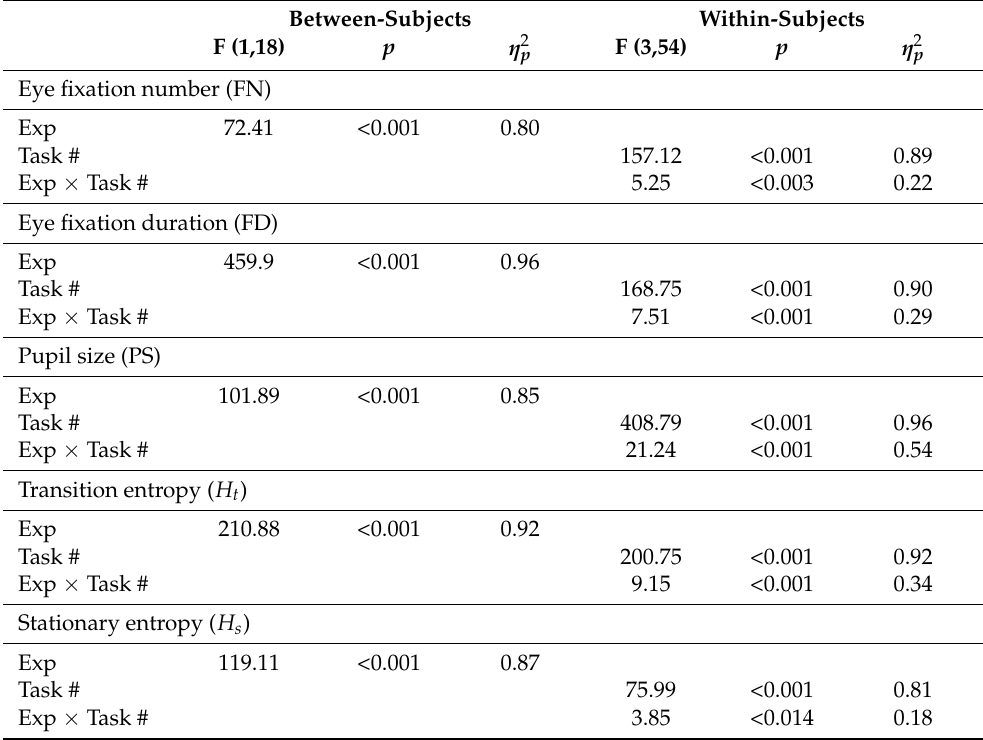
Table 4. Mixed-model analysis on eye movement measures.